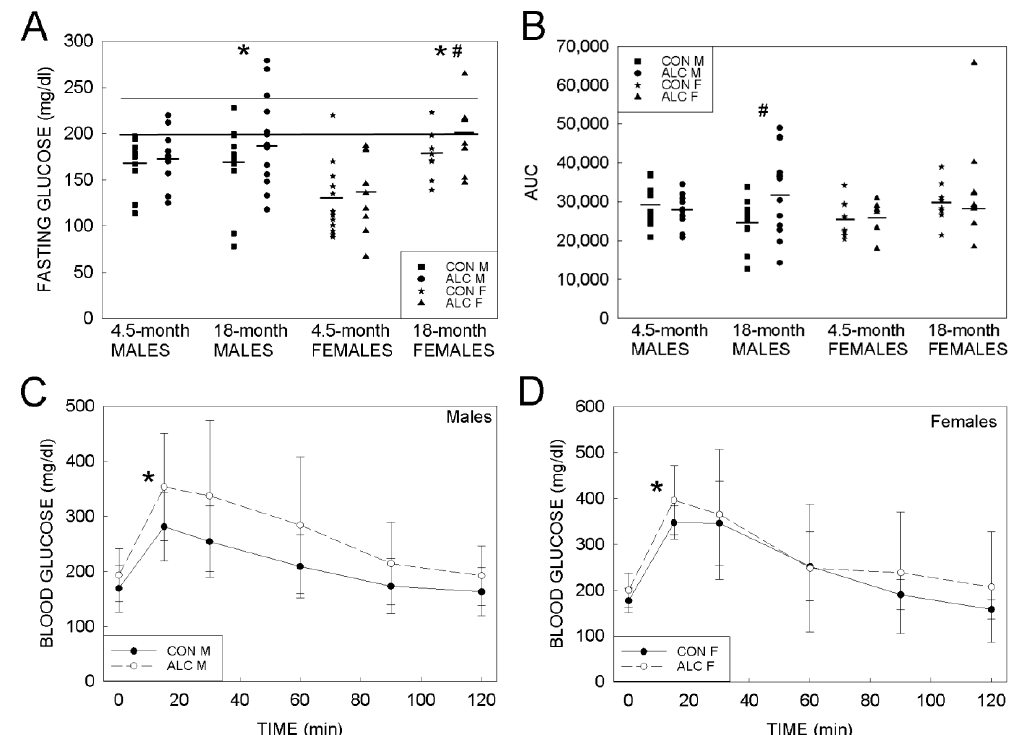
Figure 2. Metabolic responses in 18-month-old ALC and CON mice. ( A ) Fasting blood glucose at an age of 4.5 months and 18 months. At an age of 4.5 months, fasting glucose does not differ between CON and ALC males and females. At an age of 18 months, ALC females have higher fasting glucose than 4.5-month-old ALC females. Mean fasting glucose was greater in ALC than CON offspring. Lower line indicates fasting blood glucose ≥ 200 mg/dL (prediabetes) and upper line ≥ 240 mg/dL (diabetes). Symbols represent values for individual animals; bars indicate the mean response. ( B ) Glucose clearance in the intraperitoneal glucose tolerance test, presented as area-under-the-curve (AUC). Symbols represent values for individual animals; bars indicate the mean response. At 4.5 months, AUC does not differ by exposure or sex. At 18 months, male ALC mice had higher AUCs than 4.5-month-old ALC mice and CON males at both ages, suggesting reduced glucose clearance. The four 18-mo ALC mice having AUC > 40,000 also have fasting glucose ≥ 240 mg/dL in (A). ( C , D ) Blood glucose levels following intraperitoneal injection of glucose into fasting males ( C ) and females ( D ). Mean blood glucose levels were higher in ALC mice than CON. Values are mean ± S.D. Values for 4.5-month-old mice are taken from Amos-Kroohs et al. (2018) and are included for comparative purposes. *, p ≤ 0.05 for age- and sex-matched ALC versus CON. #, p ≤ 0.05 for sex-matched 18-mo versus 4.5-mo ALC mice.